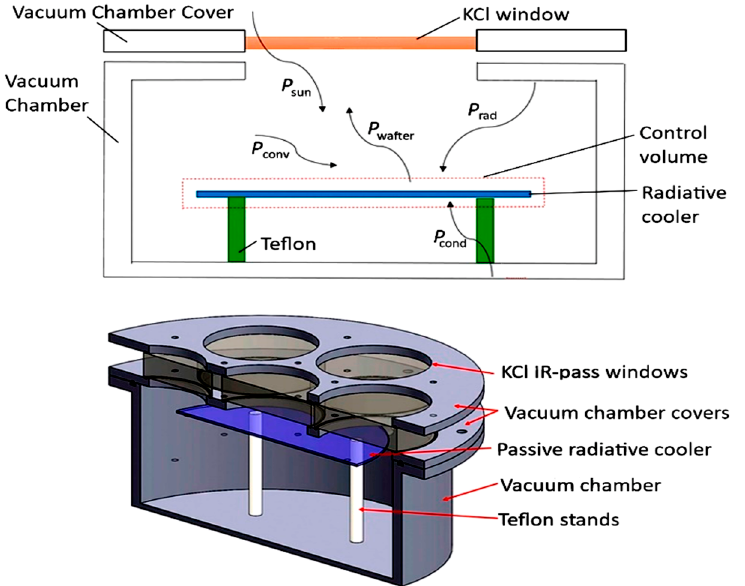
Figure 30. Vacuum chamber design as insulation and part of the convection cover for the PRC radiator [159].